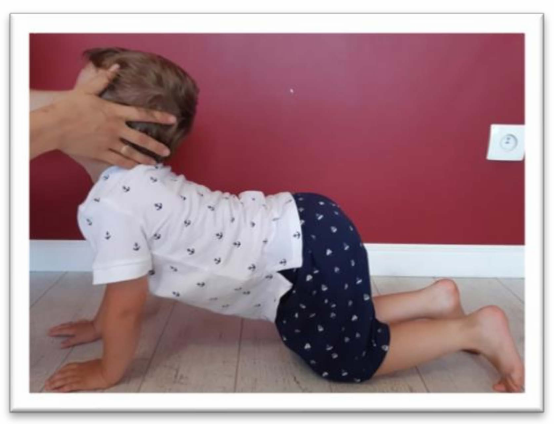
Figure 2. Position for the examination of symmetrical tonic neck reflex (STNR)